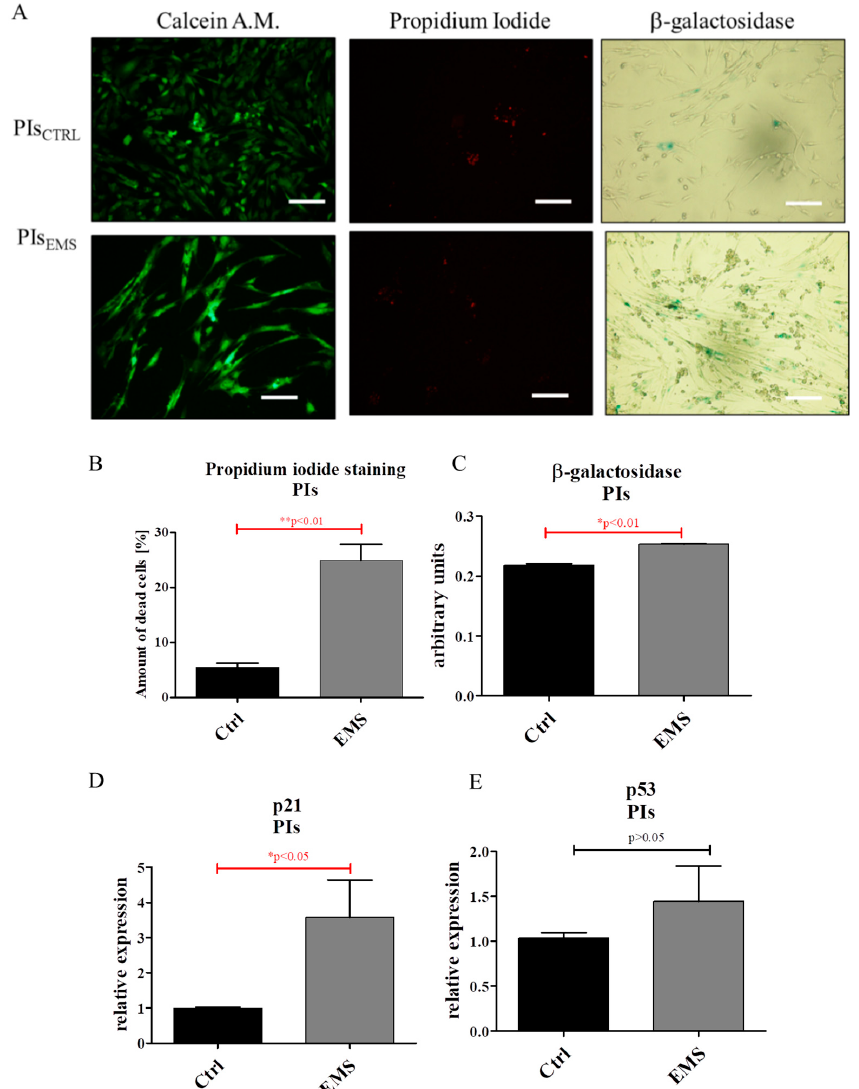
Figure 5. Assessment of senescence and apoptosis in PIs. Using epifluorescence imaging live cells were visualized with calcein while nuclei of apoptotic cells were visualized with propidium iodide ( A ). Based on the representative pictures the percentage of dead cells was calculated for both investigated populations. The obtained data clearly indicate an increased number of dead cells in PIs EMS ( B ). We also established the accumulation of senescence associated β -galactosidase ( A ). Using ImageJ, data